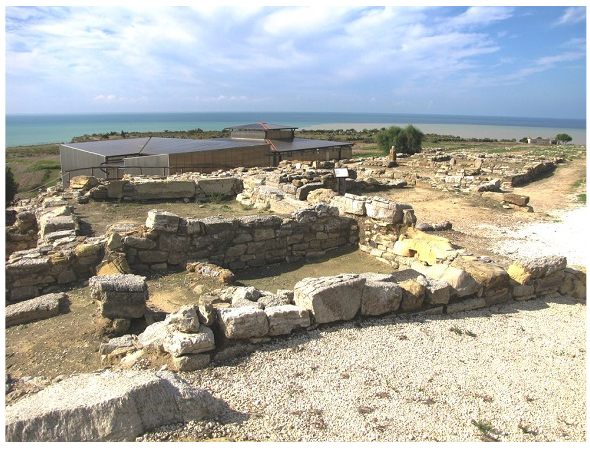
Figure 3. Buildings ruins of settlement of Strato I